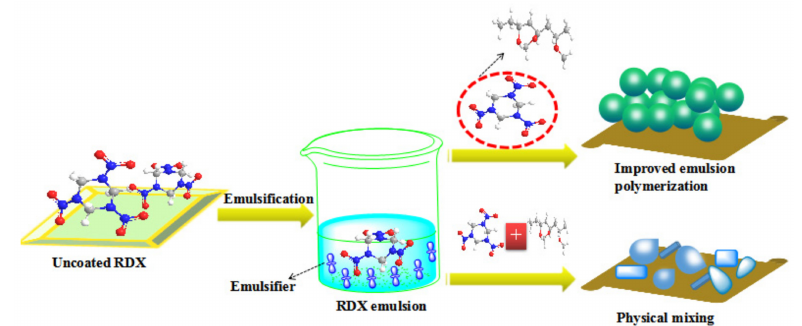
Figure 2. Schematic diagram of preparing RDX / melamine-urea-formaldehyde (MUF) composite